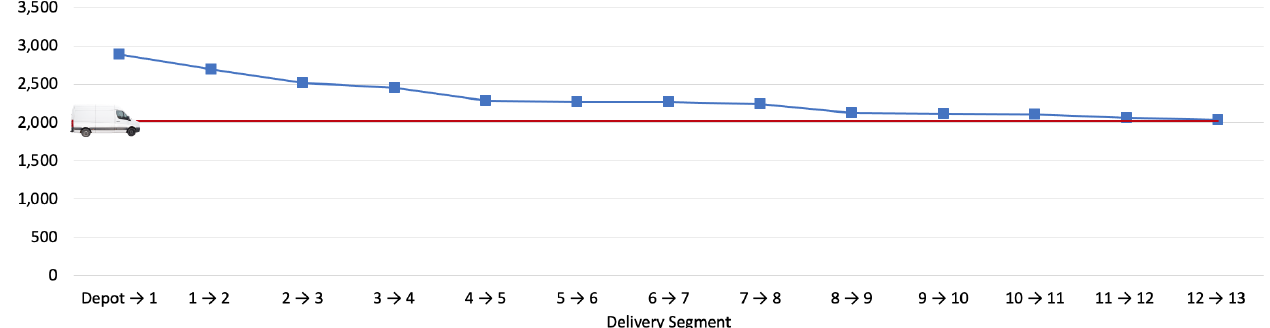
Figure 14. Van and parcels weight during the